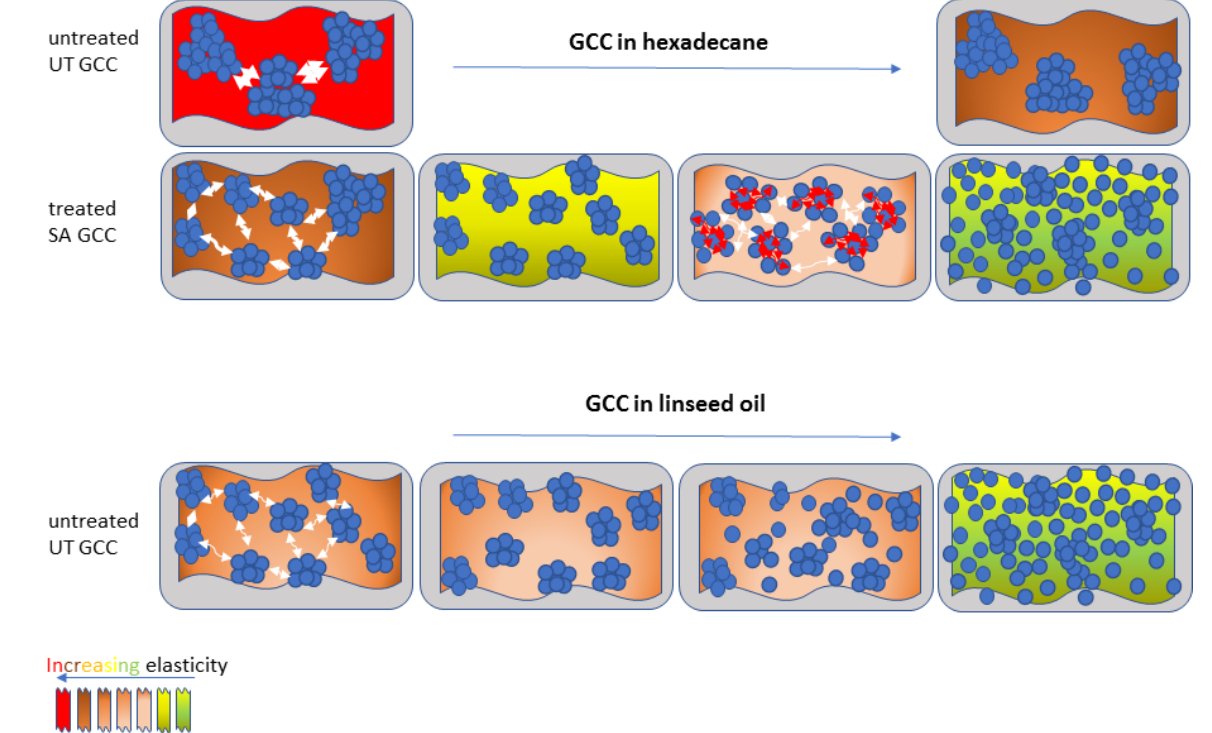
Figure 4: Schematic representation of the transitions occurring under increasing strain/shear for the two sample types in the two contrast- ing